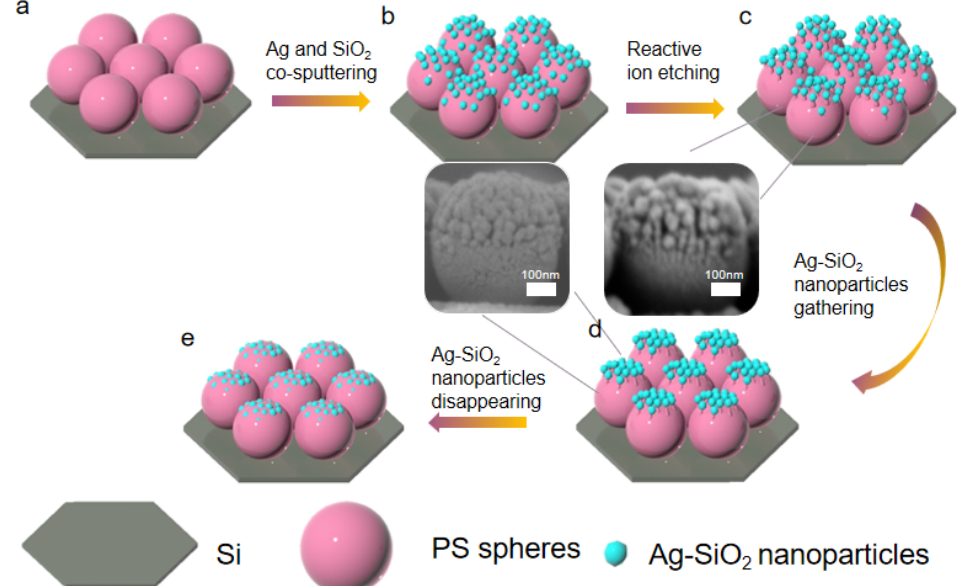
Figure 1. Schematic diagram of the preparation of SERS substrate composed of Ag nanoparticles by ion etching: ( a ) PS array by self-assembly technique; ( b ) Ag-SiO 2 nanoparticles were sputtered at the PS array; ( c ) the PS spheres surface with columnar structure after etched for 30 s; ( d ) the collapsed columnar structure and the gathered Ag-SiO 2 nanoparticles due to the heating effect after etched for 60 s; ( e ) The decreased Ag-SiO 2 nanoparticles after etched for 90